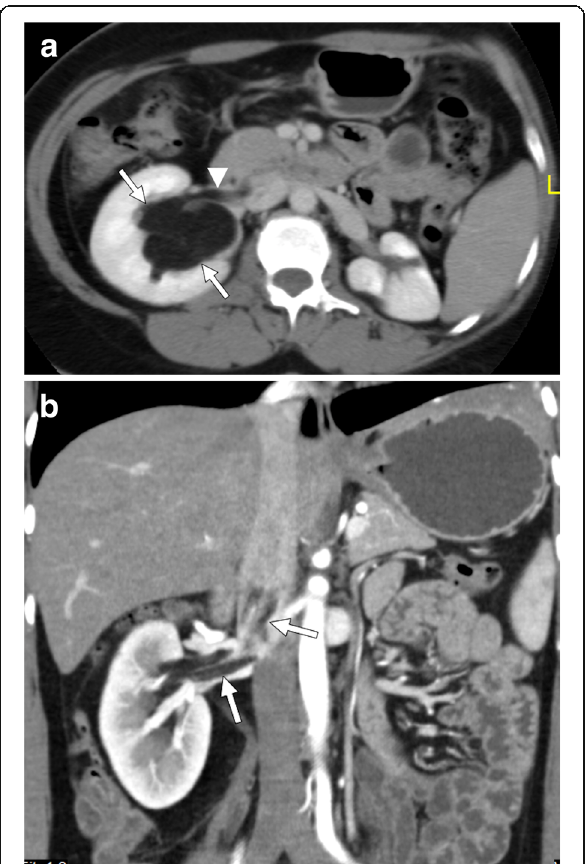
Fig. 12 A 43-year-old female with no past medical history presented with right flank pain, shortness of breath, and microscopic hematuria. a Axial plane postcontrast CT image demonstrates expansile macroscopic fat containing mass (arrows) located within the right renal sinus suggestive for AML. Also, note is made of tumor thrombus extending into the right renal vein (arrowhead). b Coronally reformatted postcontrast CT image better delineates the extension of tumor thrombus into the right renal vein and IVC (arrows). Surgery confirmed the imaging